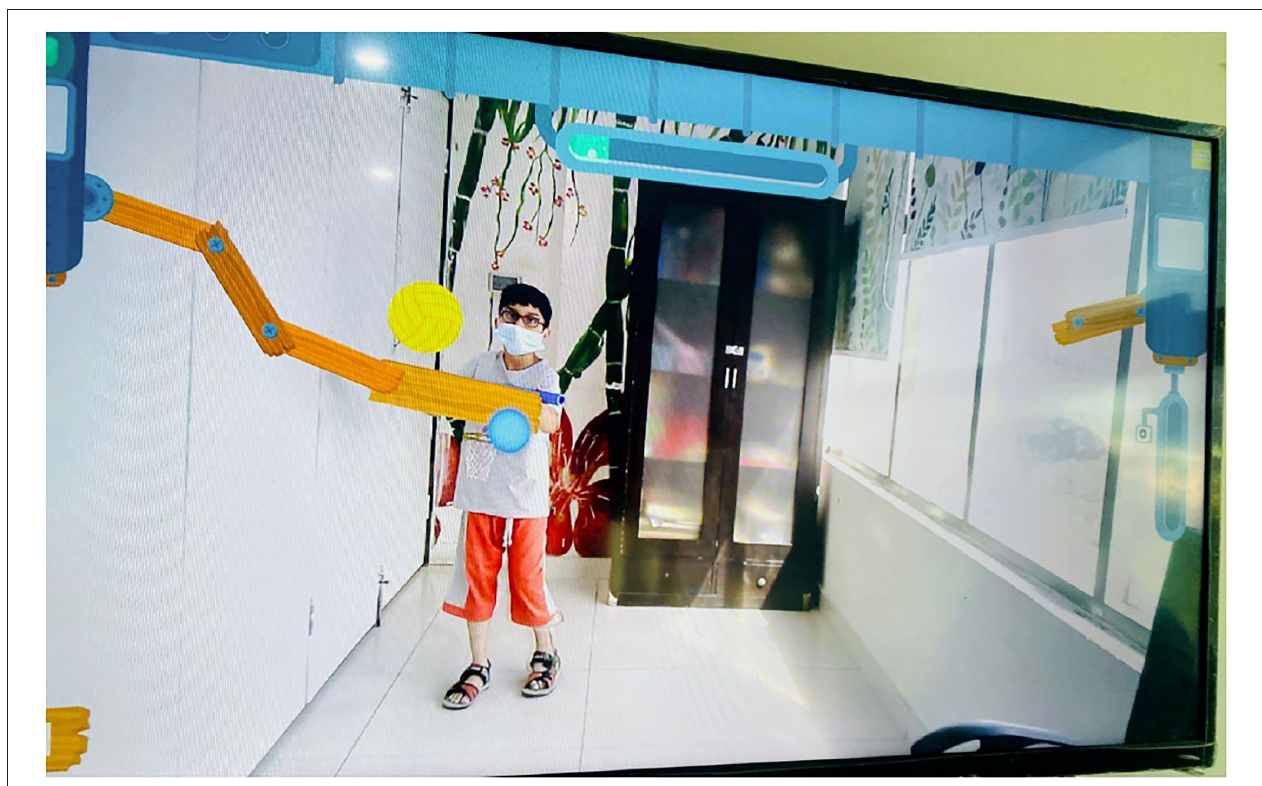
FIGURE 5 | Balance It (AR Game).